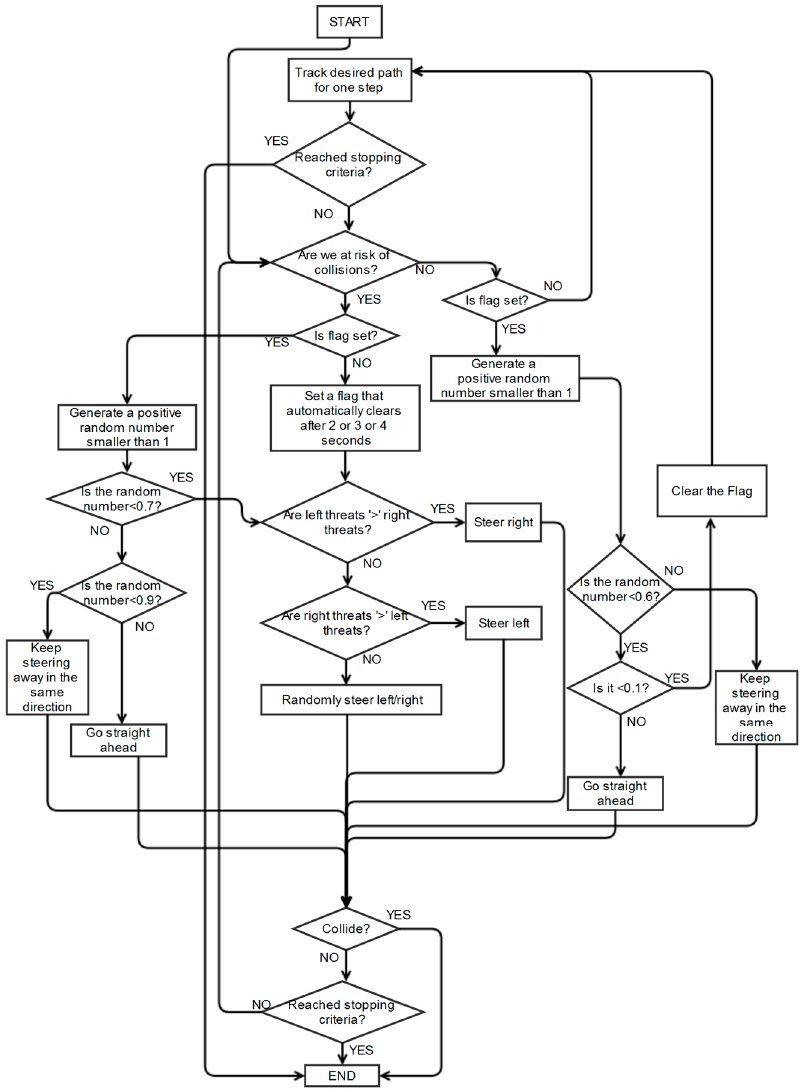
Figure 11. Flow chart of the modified simple